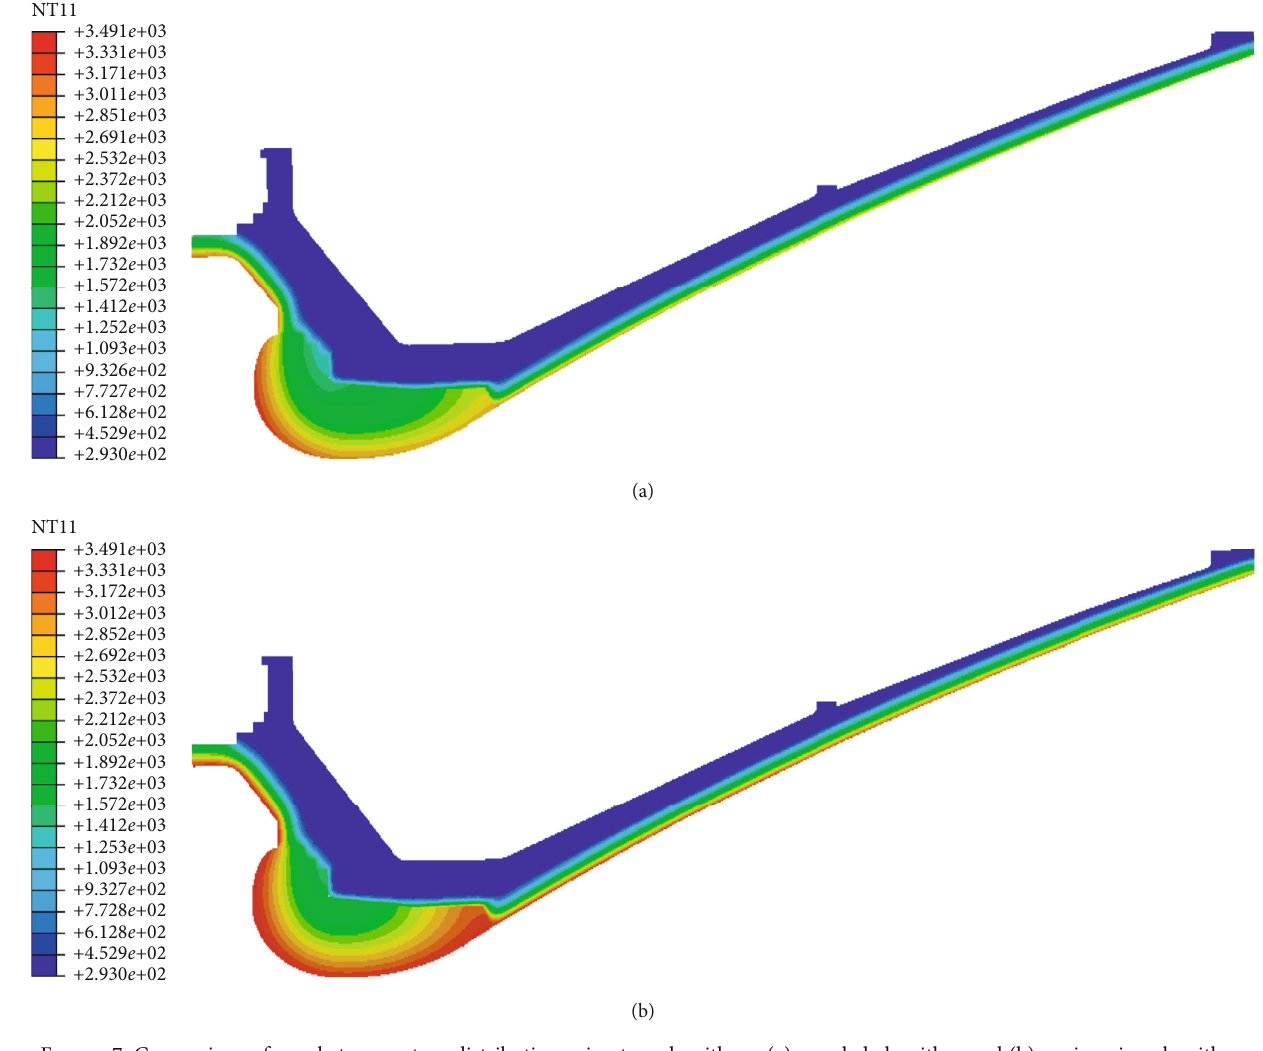
Figure 7: Comparison of nozzle temperature distribution using two algorithms: (a) coupled algorithm and (b) engineering